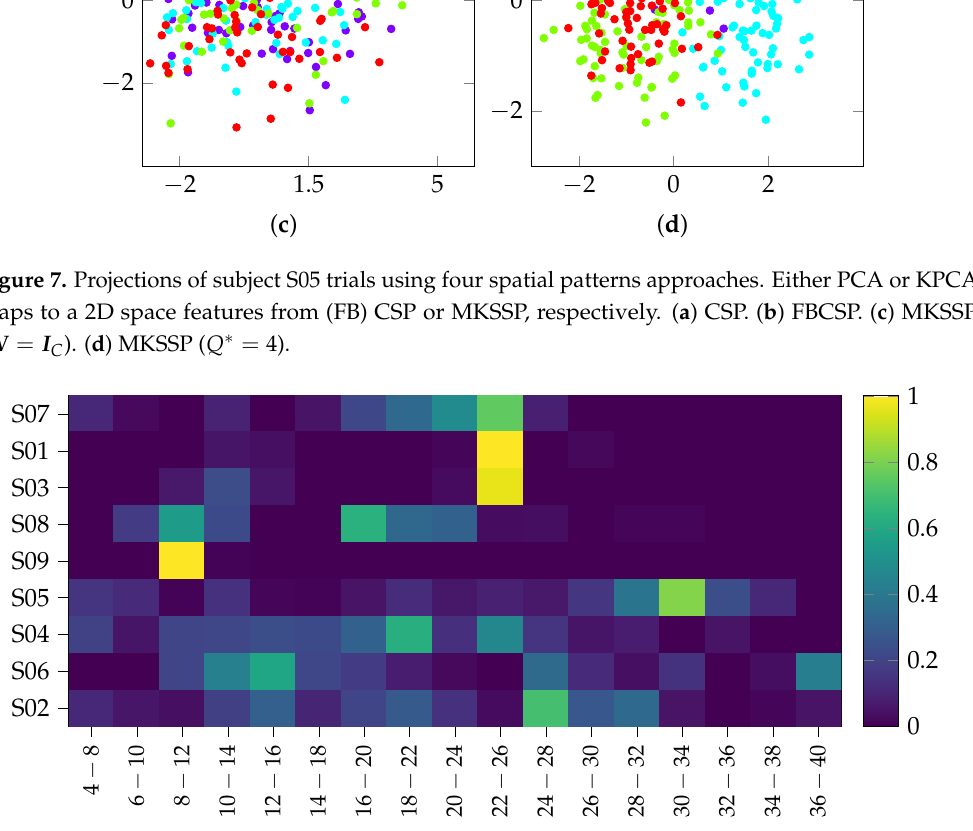
Figure 8. Multiple kernel learning (MKL) kernel weights per frequency band. Subjects are sorted according to the kappa score from the best (top) to the worst (bottom) in Y-axis. X-axis indexes each band-pass filter in the